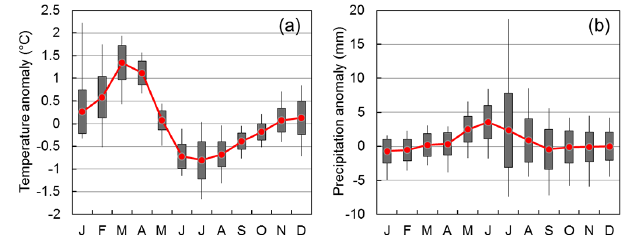
Figure 7. The seasonal cycle of (a) temperature anomalies ( ◦ C) and (b) precipitation anomalies (mm) arising from biogeophysical feed- backs for the period 2071–2100. Each box plot shows the mean (red line), one SD range (black shading) and maximum and minimum values (whiskers) for monthly climate variables.